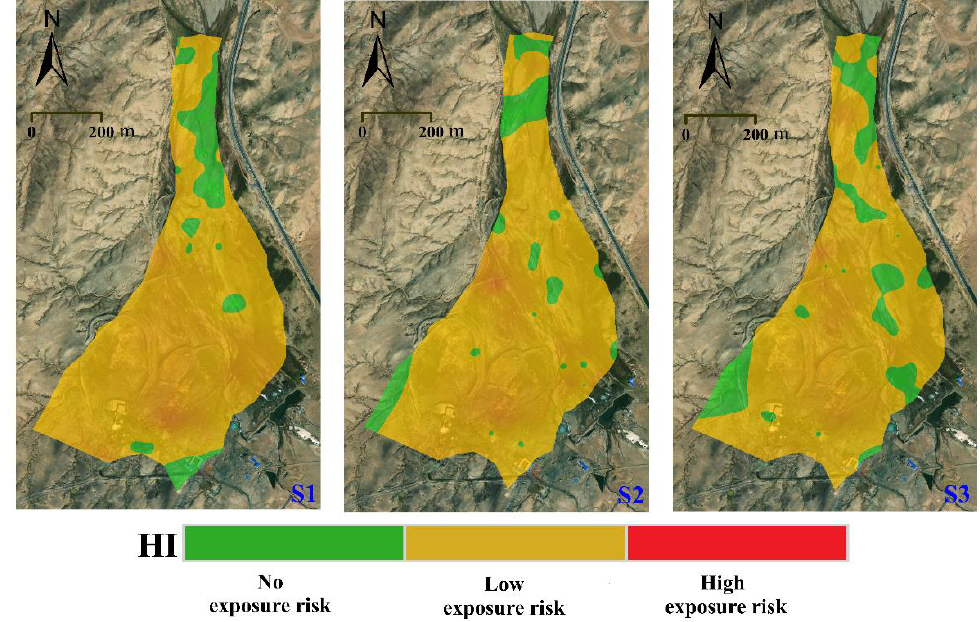
Figure 5. Evaluation results of HI in different soil layers. S1: 0–10 cm soil layer; S2: 10–30 cm soil layer; S3: 30–50 cm soil layer.